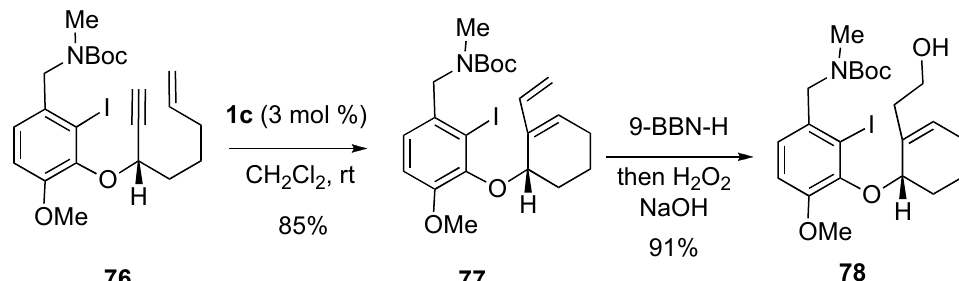
Scheme 22. Total synthesis of